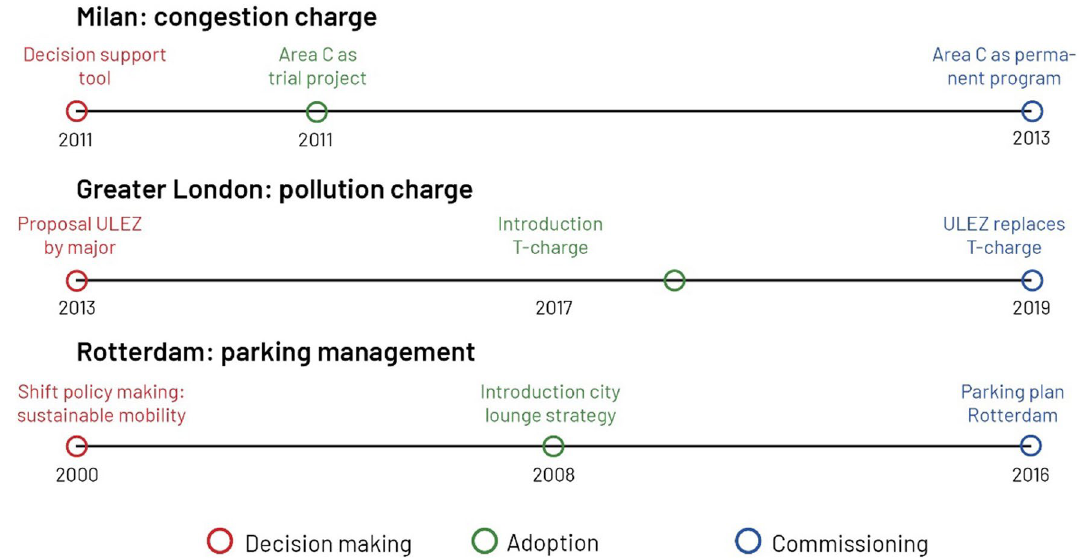
Fig. 7 Representation of case studies’ timeline and main events for the decision-making, adoption and commissioning gates (primarily pricing strategies)